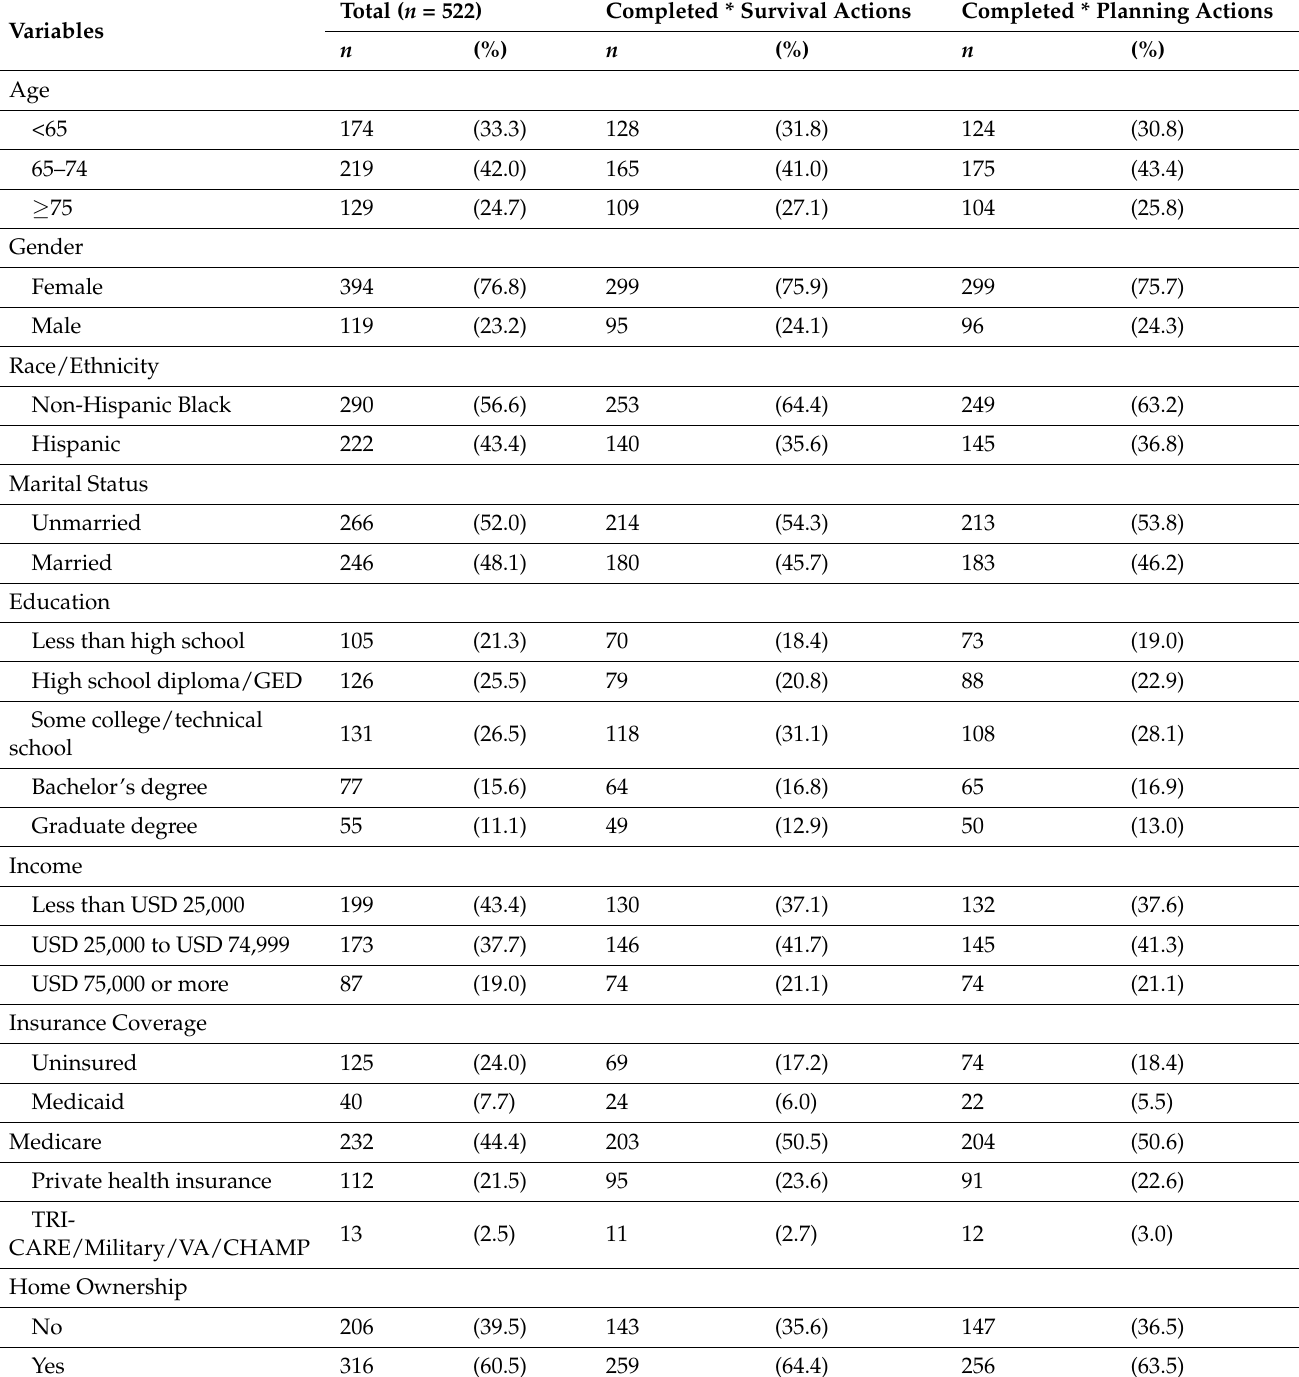
Table 1. Sample characteristics by disaster preparedness action categories ( n =